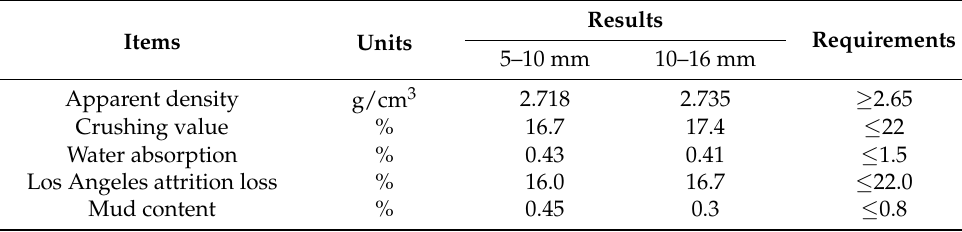
Figure 1. Result of sand screening test. Table 1. Mechanical properties of coarse aggregates.